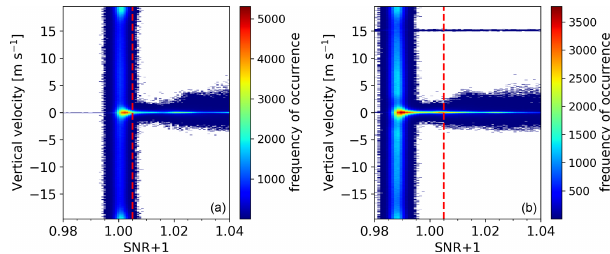
Figure 2. A 2D histogram of intensity (SNR+1) and vertical veloc- ity on 24 July 2021 from DL161 (a) and DL146 (b) . The dashed red line indicates the 1.005 of SNR+1, and the horizontal straight blue line at 15ms − 1 is the example of noise data in the lowest range